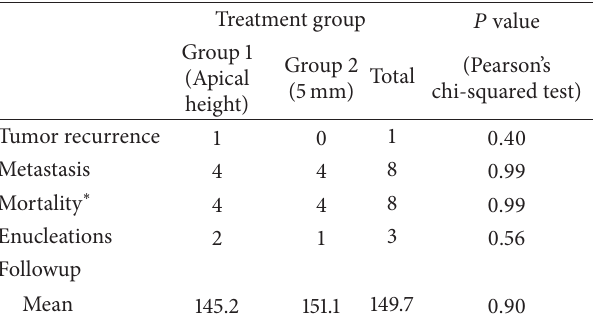
Table 2: Tumor recurrence, metastasis, mortality, enucleations, and followup interval.